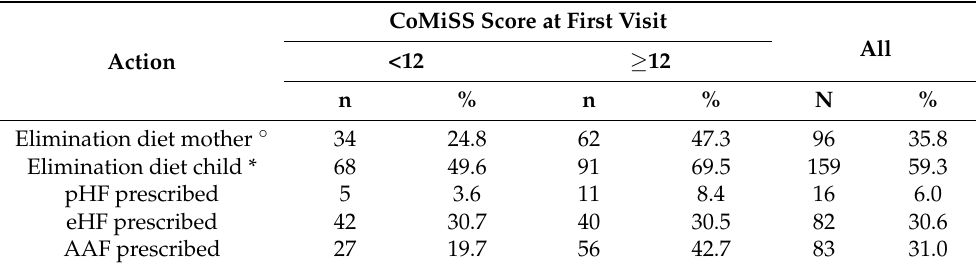
Table 8. Actions undertaken at first visit, stratified by CoMiSS at